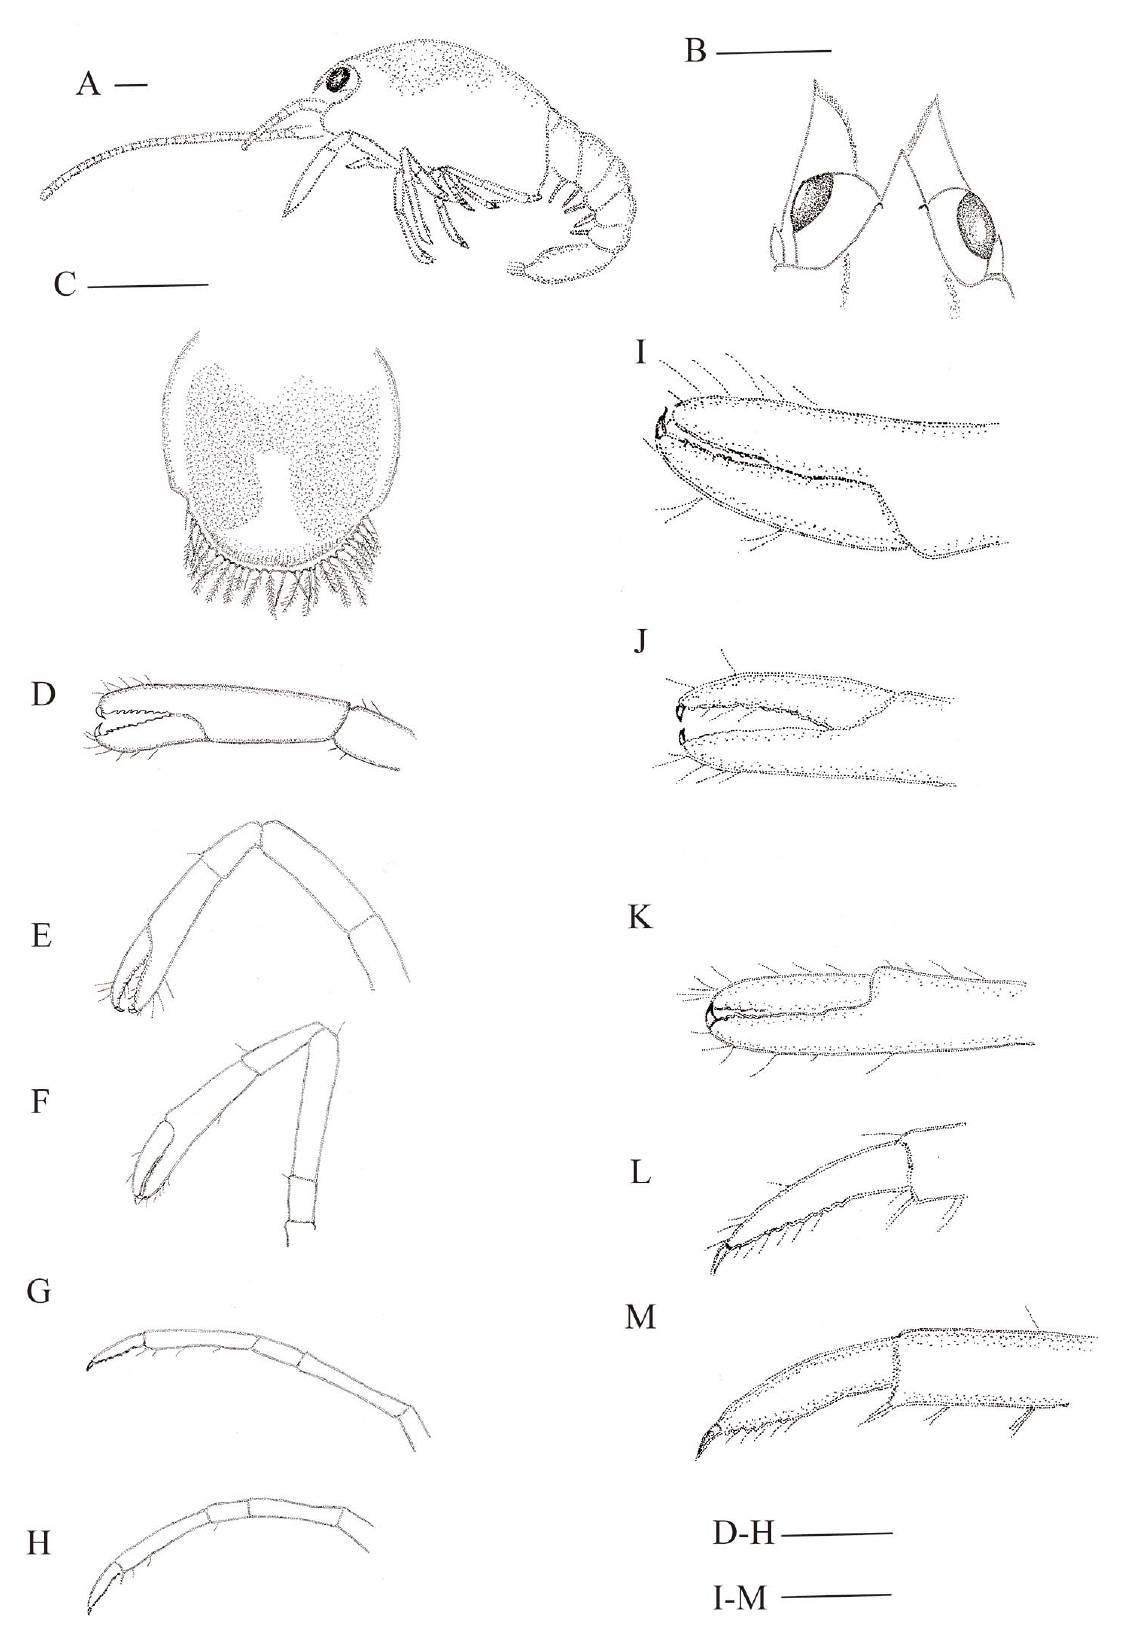
Figure 9. Juvenile Stage II of Procambarus virginalis . ( A ) Habitus, lateral view; ( B ) eyes and rostrum, dorsal view; ( C ) tail fan, dorsal view; ( D–H ) pereiopods 1–5, dorsal or lateral view; ( I–M ) distal segments of pereiopods 1–5, dorsal or lateral view. Scale bars: 0.25